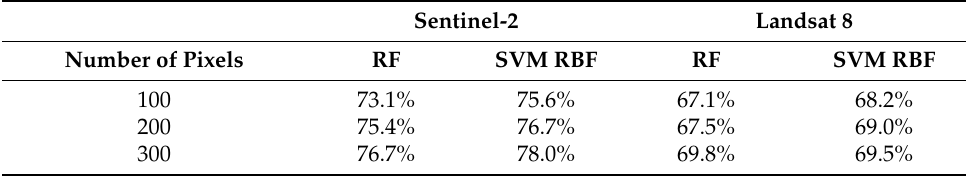
Table 11. Increases mean OA accuracies under changing the number of